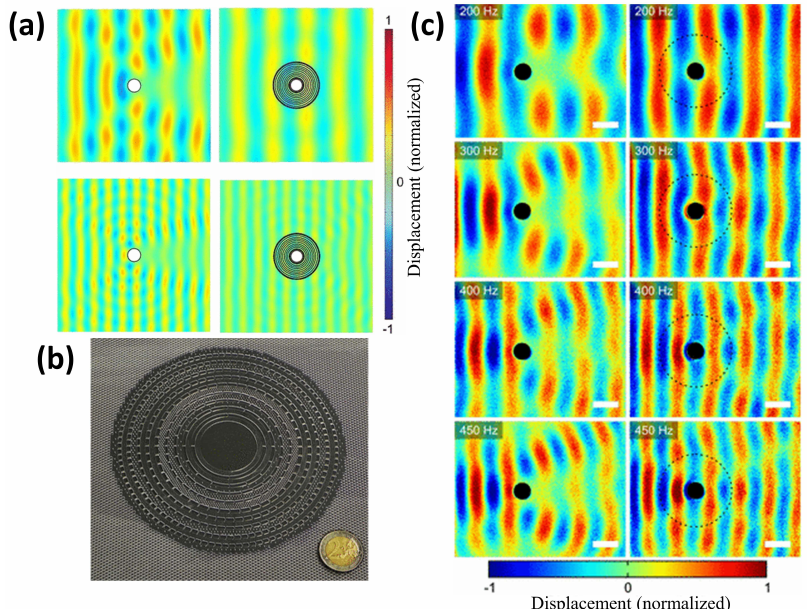
Figure 8. ( a ) Left: displacement field scattered by an obstacle for a plane wave of frequency 60 Hz (upper), 150 Hz (lower). Right: displacement field scattered by obstacle surrounded by cloak layers for a plane wave of frequency 60 Hz (upper), 150 Hz (lower); ( b ) Designed elastic cloak before filling with PDMS; ( c ) Displacement field for plane waves with frequencies of 200, 300, 400 and 450 Hz from the top. Left column: without cloak and right column: with cloak. Dashed black circles: outer radius of the cloak region; white scale bar: 5 cm. ( a ) adapted from [103]. ( b , c ) adapted from